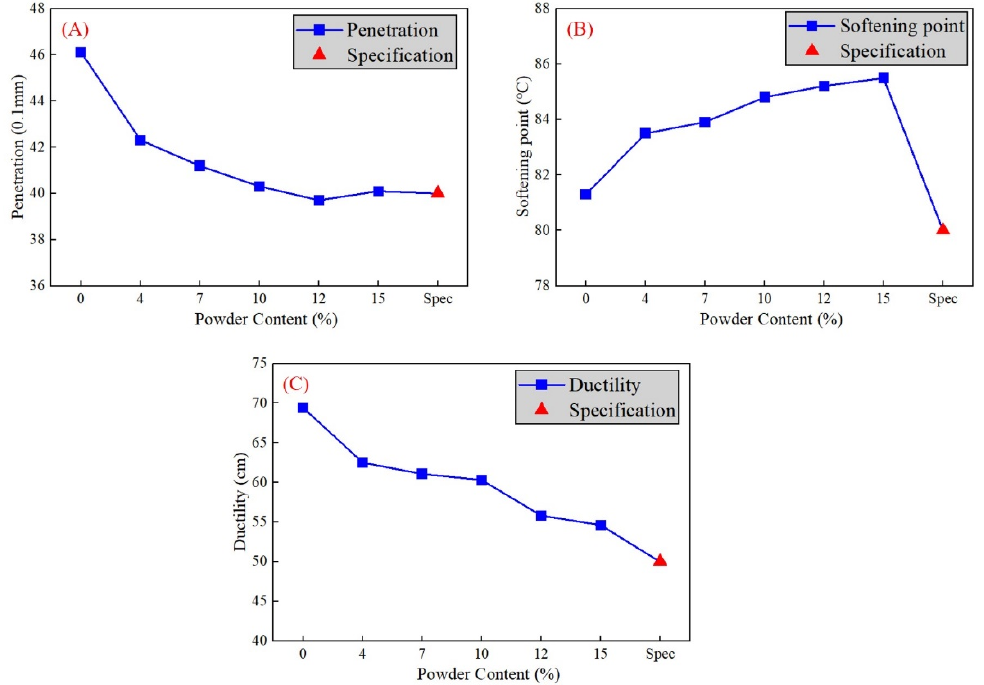
Figure 6. Variation trend of ( A ) penetration, ( B ) ductility, and ( C ) softening point with the increase of phosphorus tailing fine powder content.